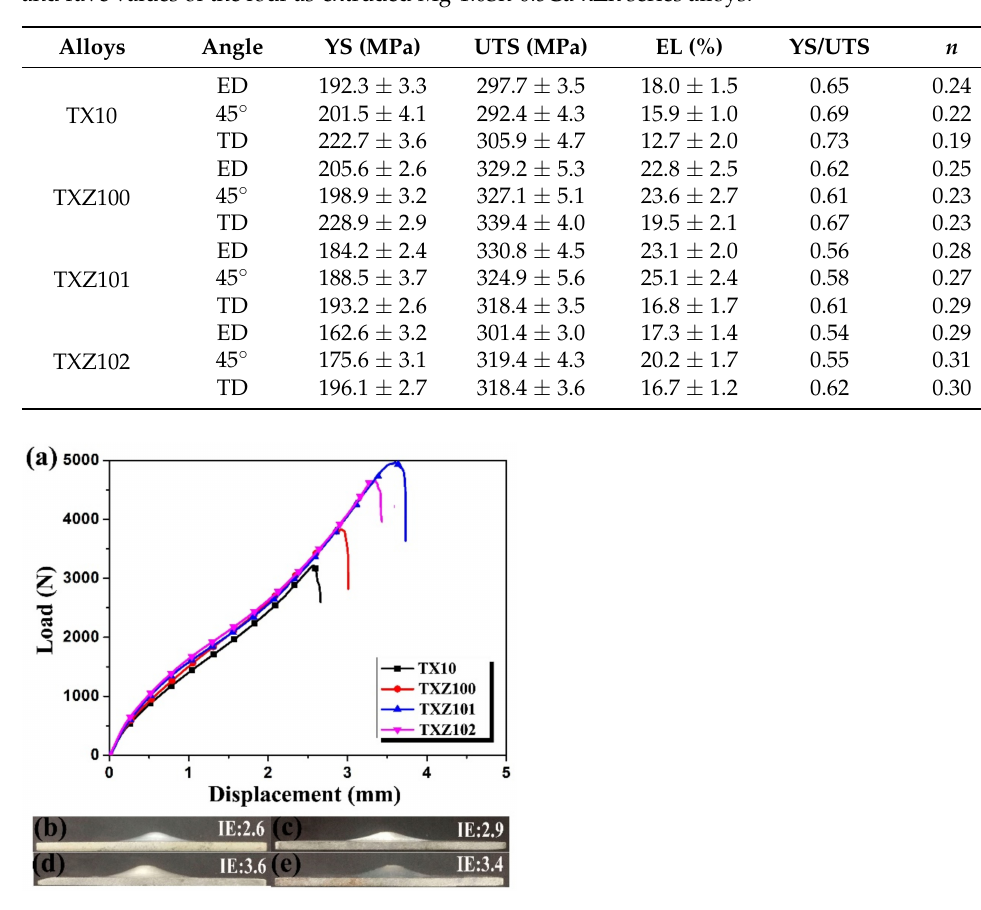
Figure 5. ( a ) Load–displacement curves of the four as-extruded Mg-1.0Sn-0.5Ca-xZn series alloys; ( b – e ) images of the sheet samples after the Erichsen test of the TX10, TXZ100, TXZ101, and TXZ102